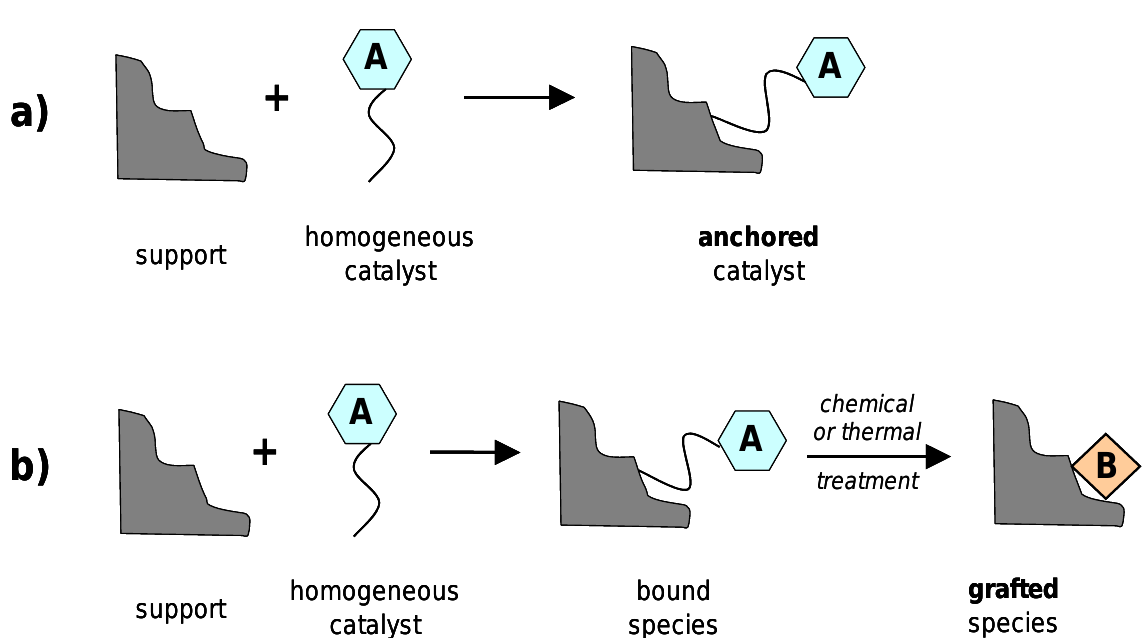
Figure 2. Post-synthesis covalent functionalization of inorganic oxide supports: anchoring and grafting.